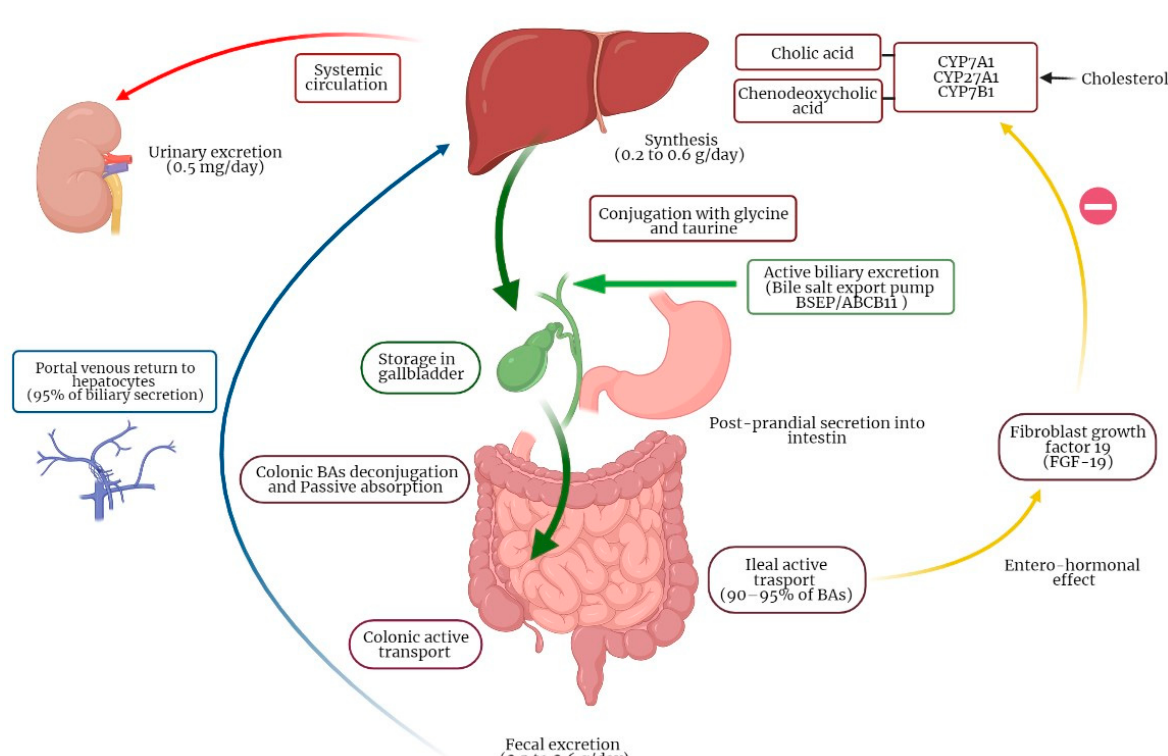
Figure 1. Enterohepatic circulation of bile acids.